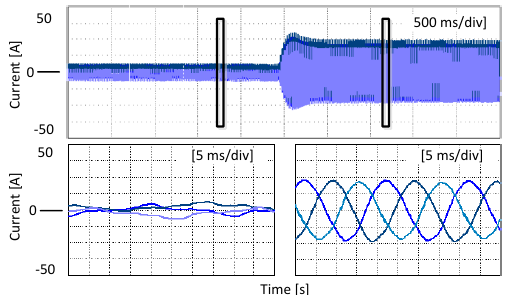
Figure 10. Waveforms of the current injected by the power converter during start-up and power step-up.